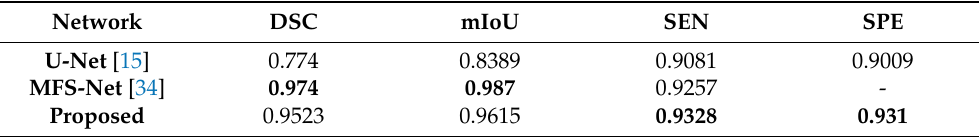
Table 4. Comparison of results of different network architectures on the ISIC 2017 Task1 dataset.